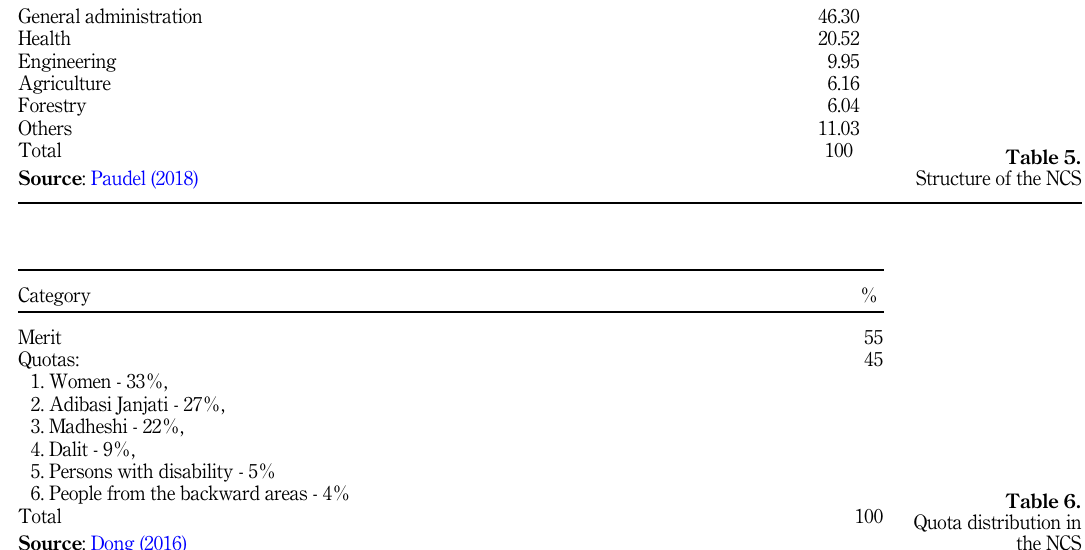
Table 6. Quota distribution